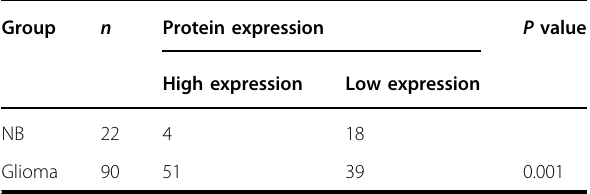
Table 1 p75CUX1 protein expression between glioma and non-tumor brain (NB) tissues.